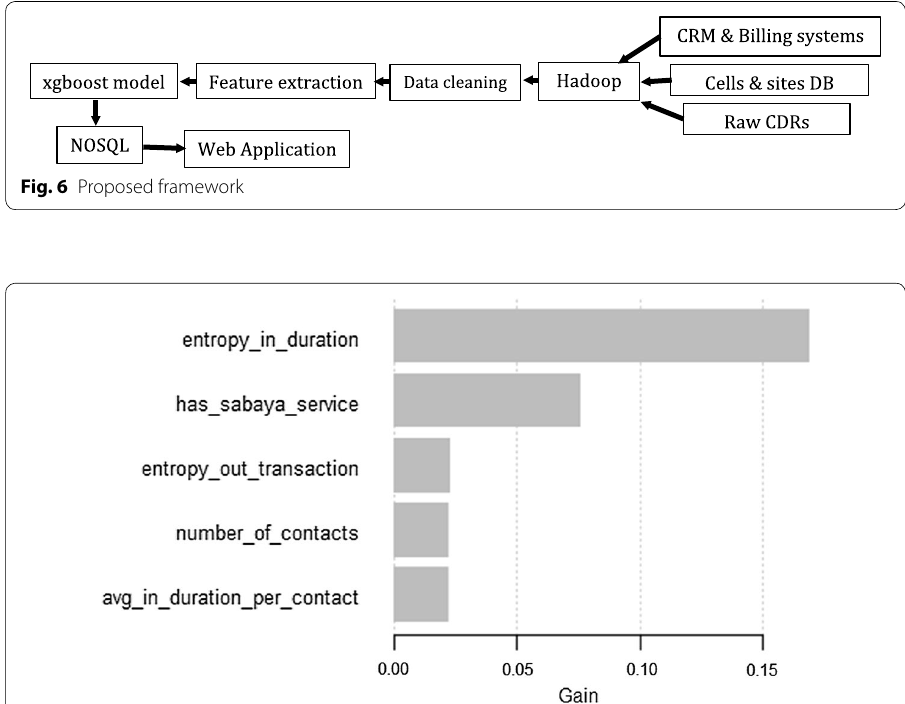
Fig. 7 Top 5 predicted features for